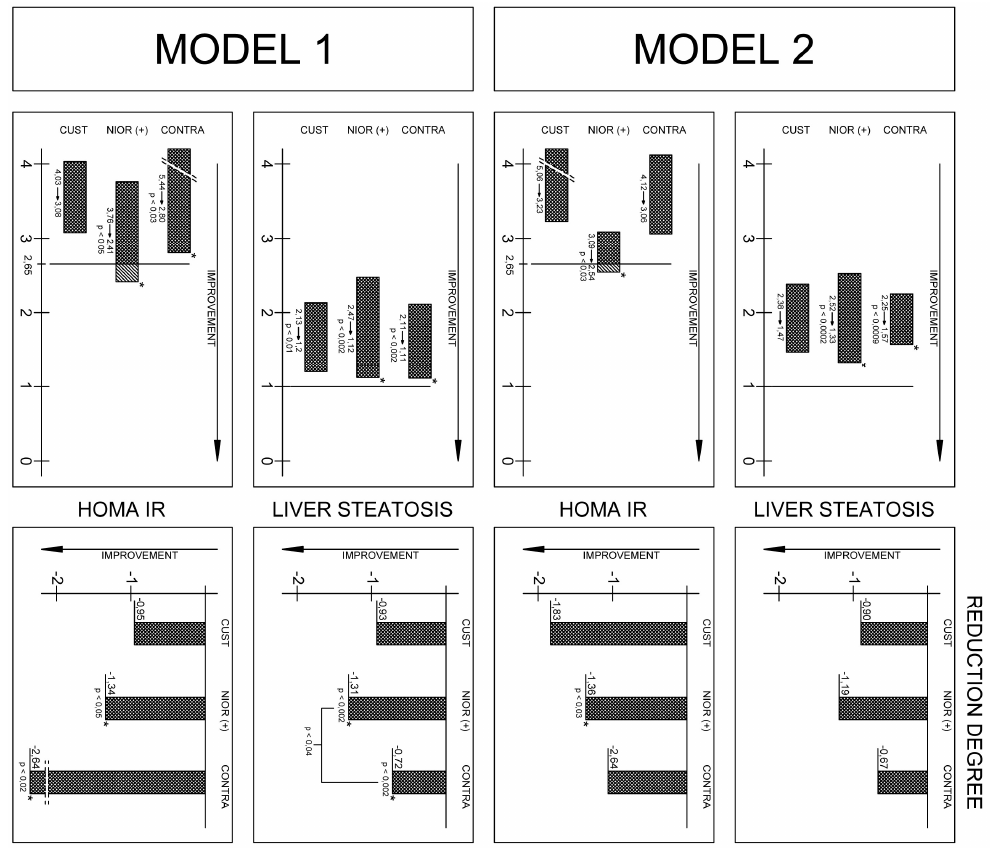
Figure 1. Changes in biochemical blood parameters in Model 1 and 2Note: All data represent the mean (standard deviation).